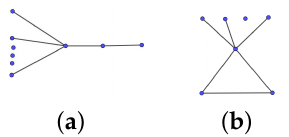
Figure 1. Graphs K (cid:48)